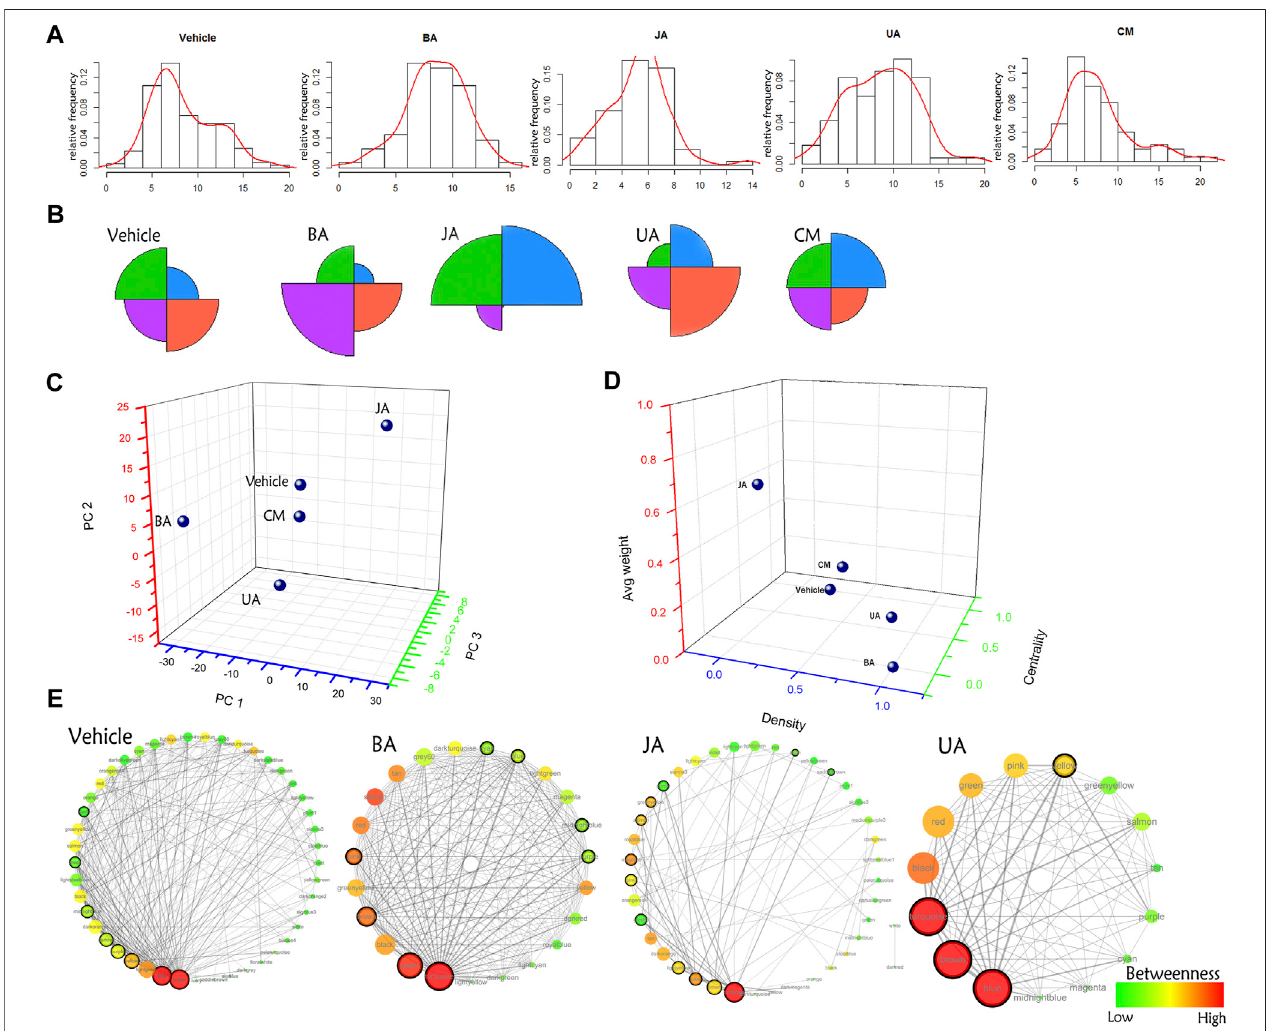
FIGURE3| ComparisonofdistributionoftheIMCCscoreandglobalmodularmaprewiring. (A) TherelativedistributionoftheIMCCscore.The X -axisisthe-log2of the IMCC score. (B) Stargraph ofthe relative accountofthe IMCC scoredistributingin four intervals( − ∞ , 5.2] (5.2 – 7.3] (7.3 – 10.2] (10.2 − + ∞ ].Thesefour intervals were indicated by black, red, green, and blue, respectively. (C) The principal component analysis of distribution of the IMCC score in each group. Each interval is set as variable, and relative frequencies in each interval are set as values of corresponding variables. (D) Euclidean distance of architecture of modular map in different groups. Three indexes (average weight, density, and centrality) were used to constitute the dimensions ofspaceeuclidean distance calculation. (E) Modular map based on IMCC across conditions. Each circle in modular map represents a module, the color of which indicates the betweenness in the corresponding modular map. Circles with black solid line around are connectors (modules) identi fi ed by edge weight distribution for further GO enrichment